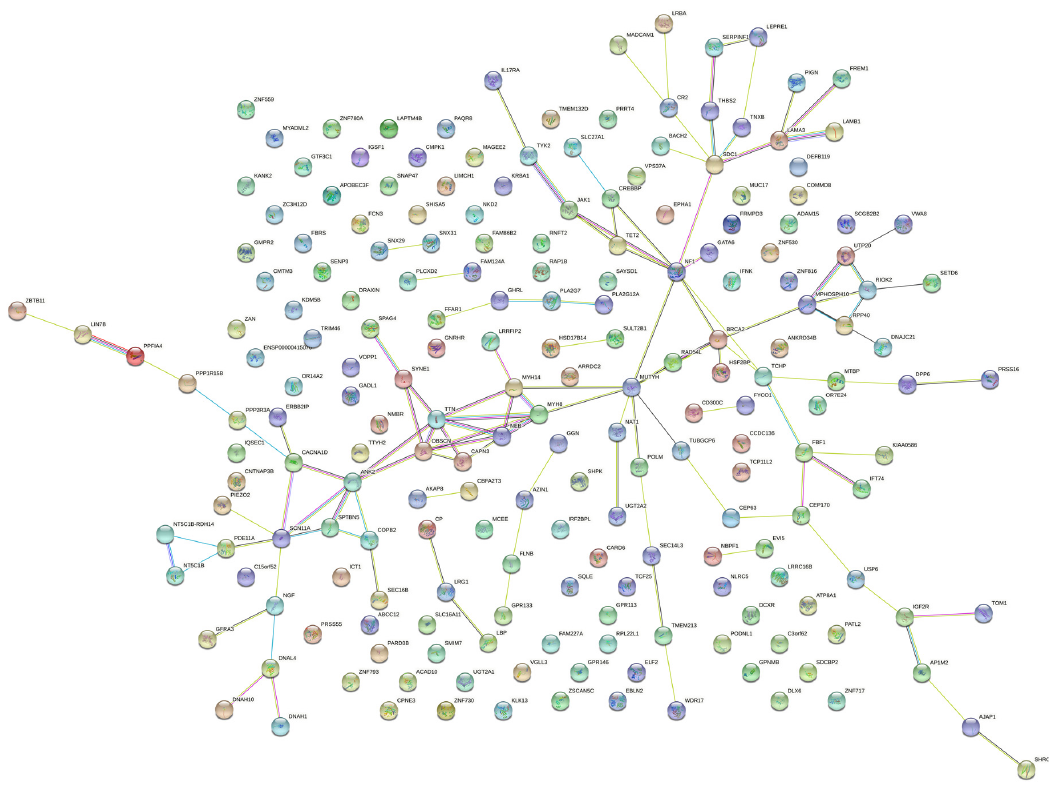
Figure 4. Protein–Protein Interaction (PPI) network for genes on which prioritized variants were found in teratozoospermic men. The network includes 202 nodes and 120 edges. PPI enrichmen p value is